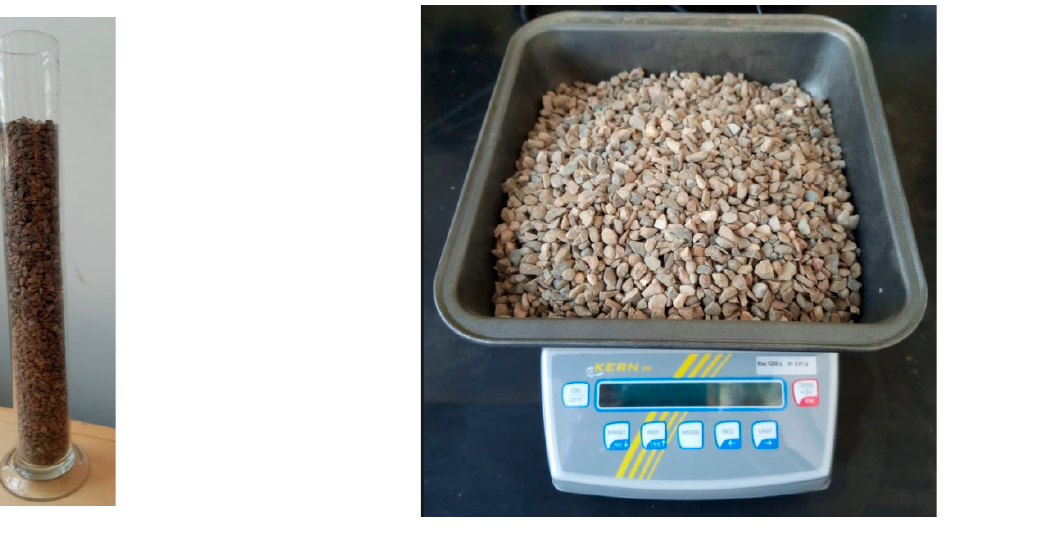
Figure 4. Determination of bulk particle density.